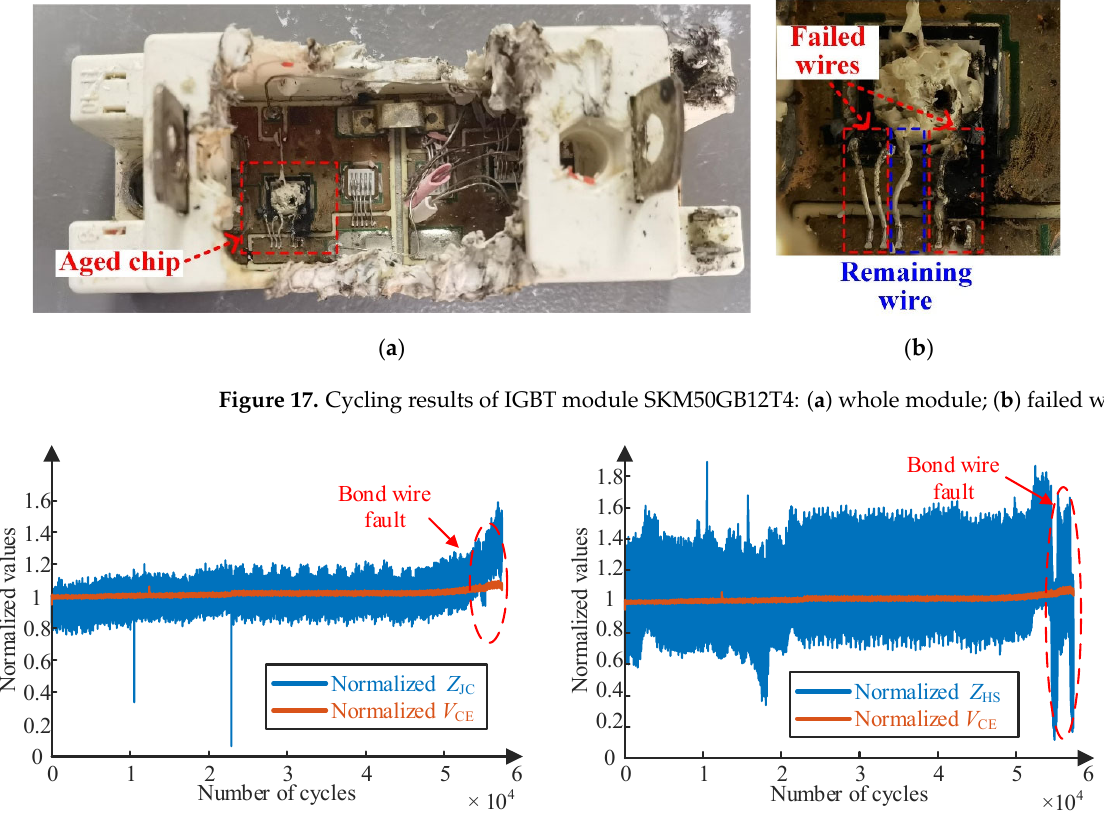
Figure 17. Cycling results of IGBT module SKM50GB12T4: ( a ) whole module; ( b ) failed wires.